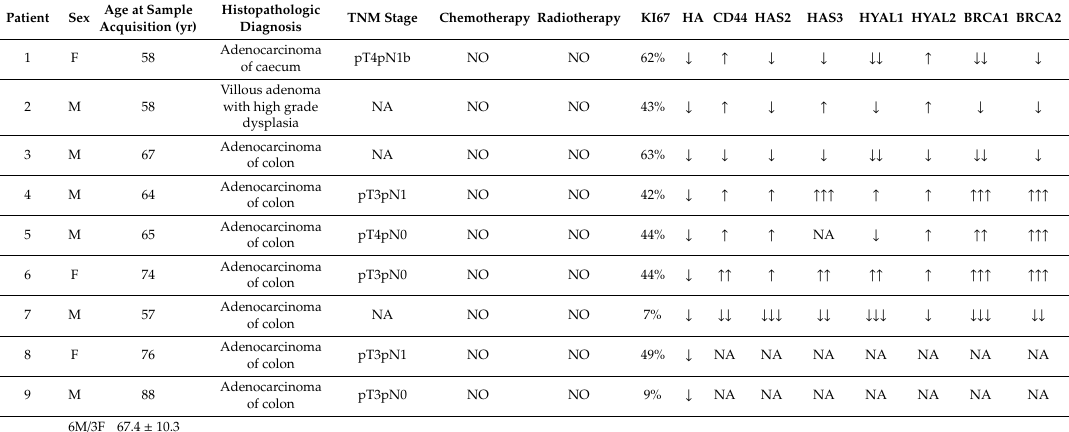
Table 3. Summary of the results for the colorectal tumor patients.